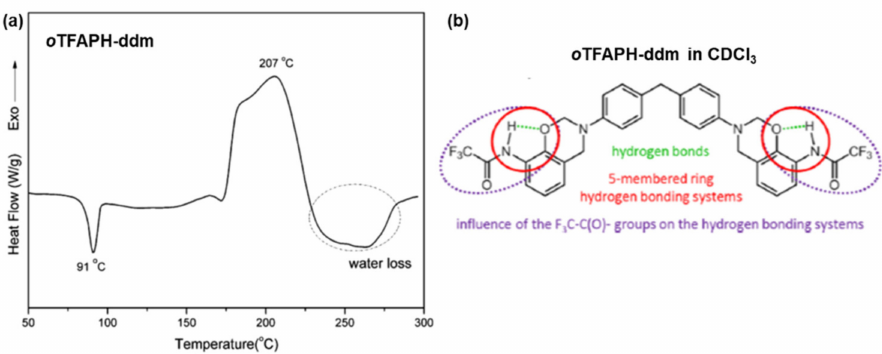
Figure 28. ( a ) DSC thermogram of o TFAPH-ddm and ( b ) five membered-ring hydrogen-bonding system at each side of the symmetric resin in chloroform. Copyright 2017. Reproduced with permission from American Chemical